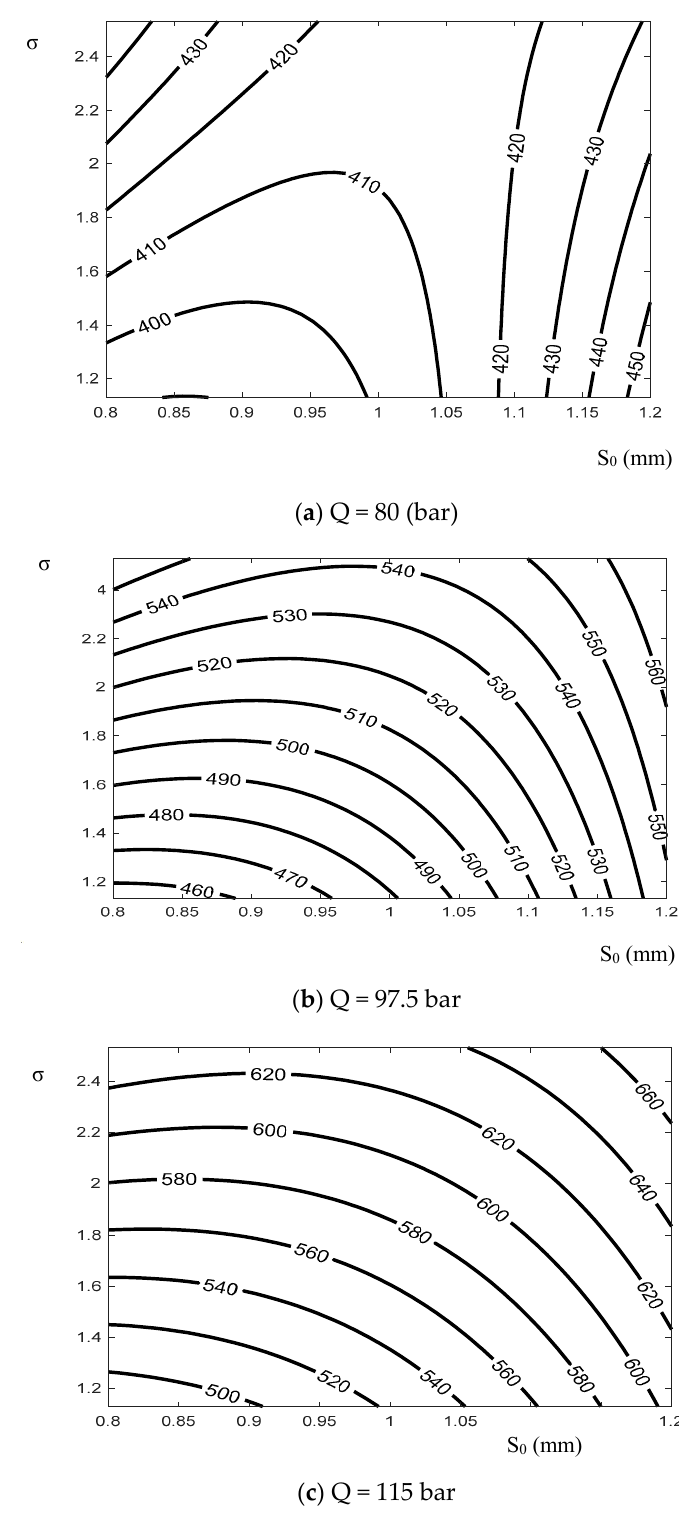
Figure 10. Dependence of the maximum forming pressure on the thickness and the ratio of stress.